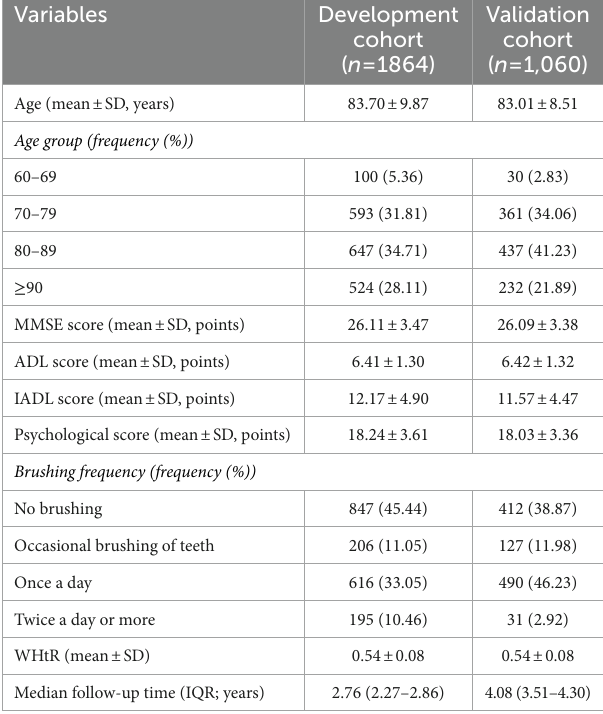
TABLE 1 Baseline characteristics of the participants in the development and validation